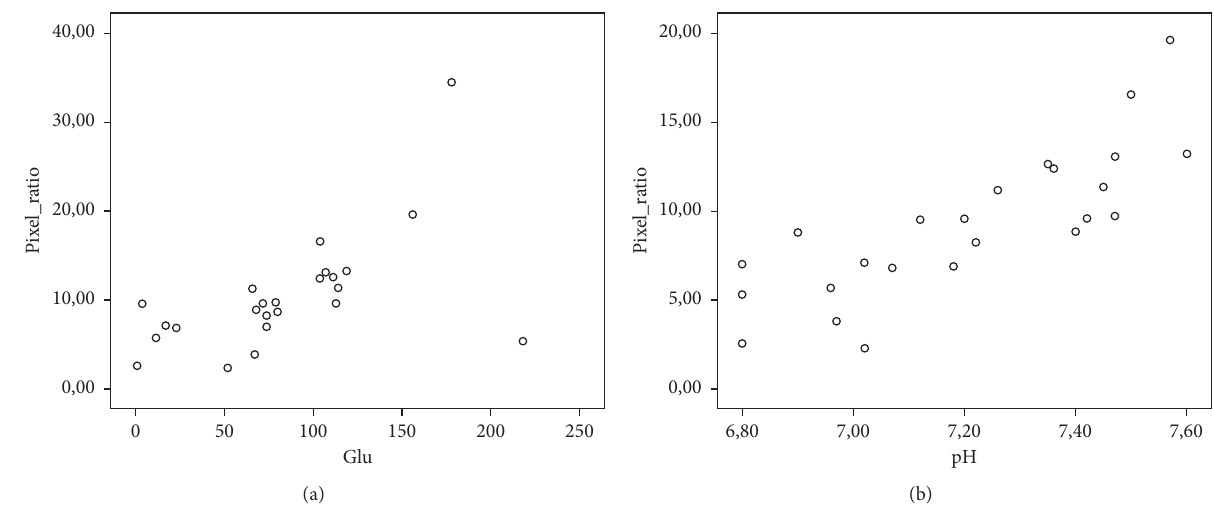
Figure 3: Scatterplot of the predictors (glucose and pH) joining the regression model with the dependent variable (hypoechogenicity index, HI) ( p � 0 . 022, r � 0.474 for glucose, p < 0 . 001, r � 0.811 for pH). Pixel ratio stands for HI.